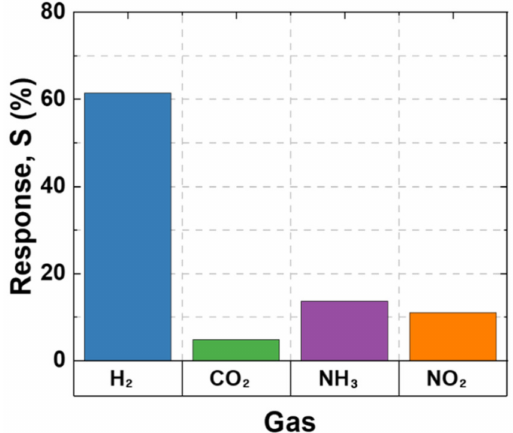
Figure 9. Gas selectivity of SnO 2 thin film.